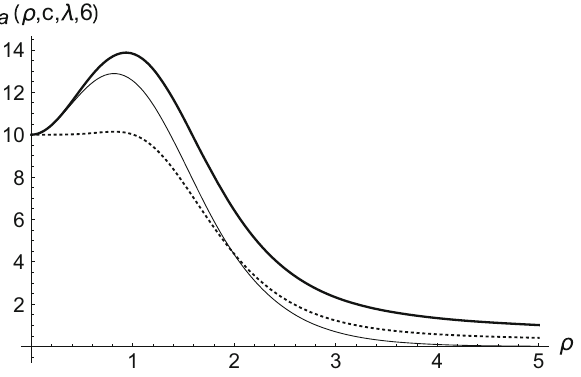
,λ = 1 and p = 1 (dotted line), p = 2 Fig. 8 Ricci scalar for c = 2 5 (thin line), p = 10 (thick